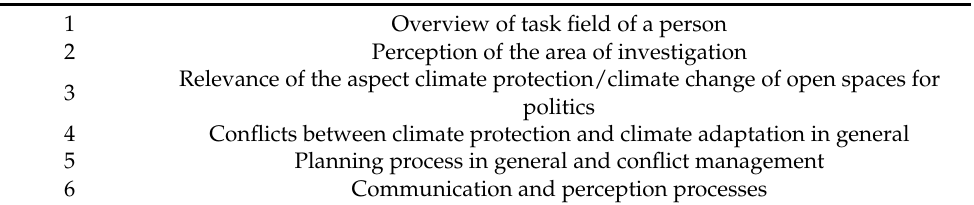
Table A4. Interviewer guidelines (translated,